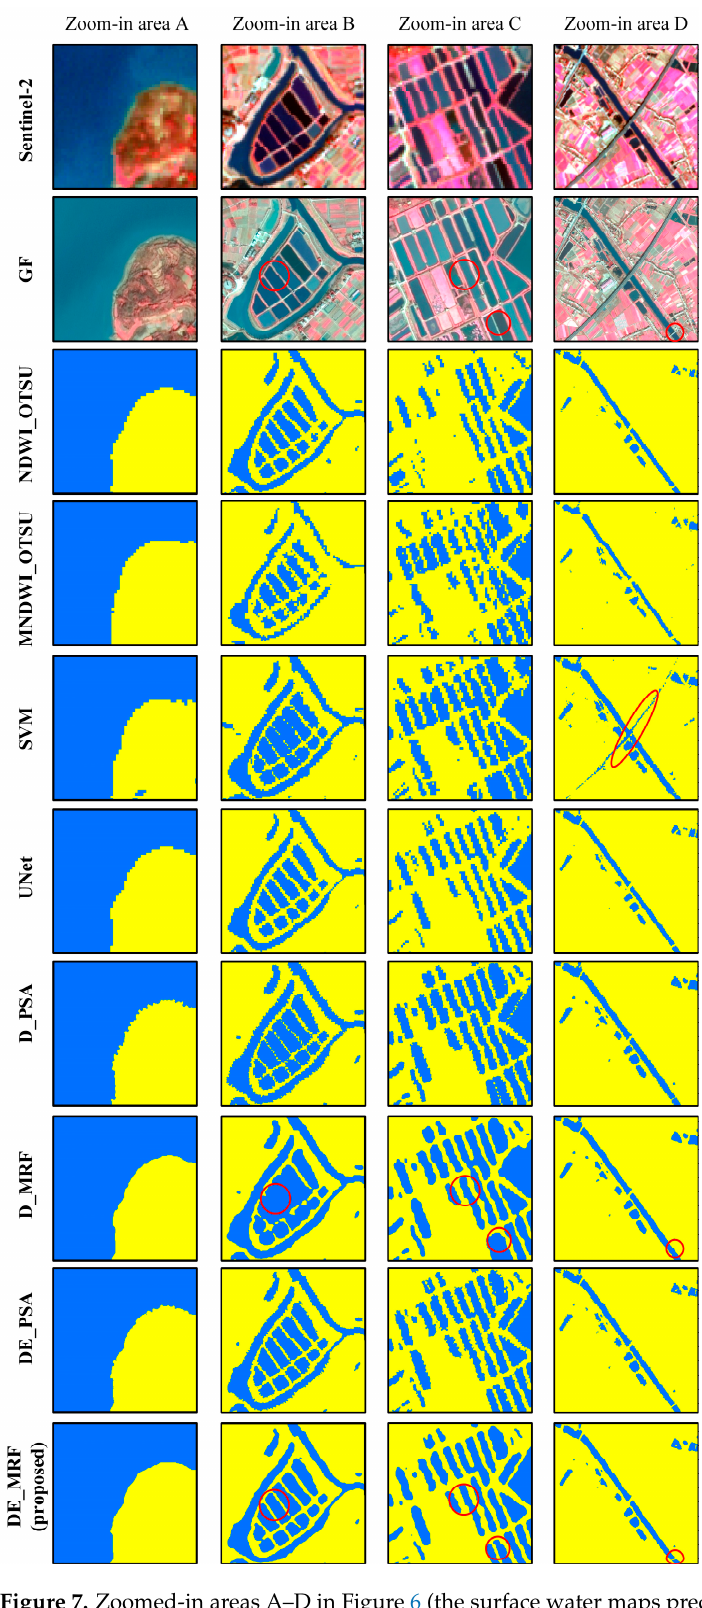
Figure 7. Zoomed-in areas A–D in Figure 6 (the surface water maps predicted by di ff erent methods).